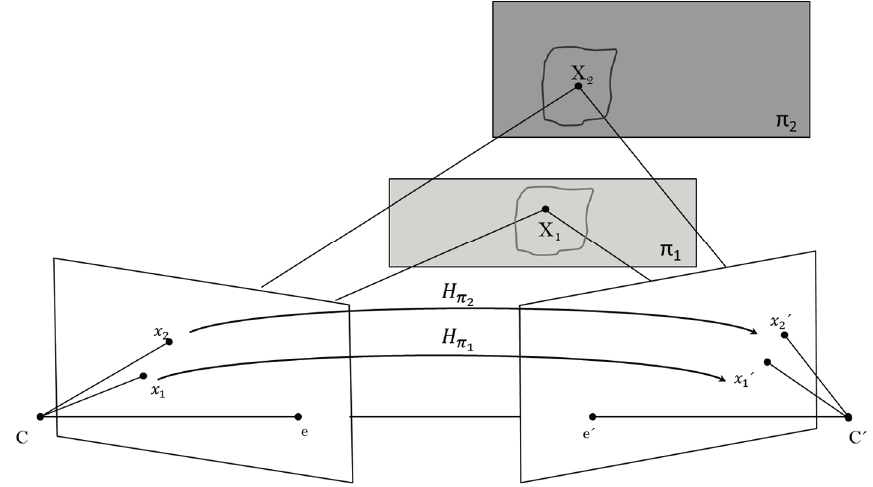
and (cid:2024) on a (cid:2869) (cid:2870)